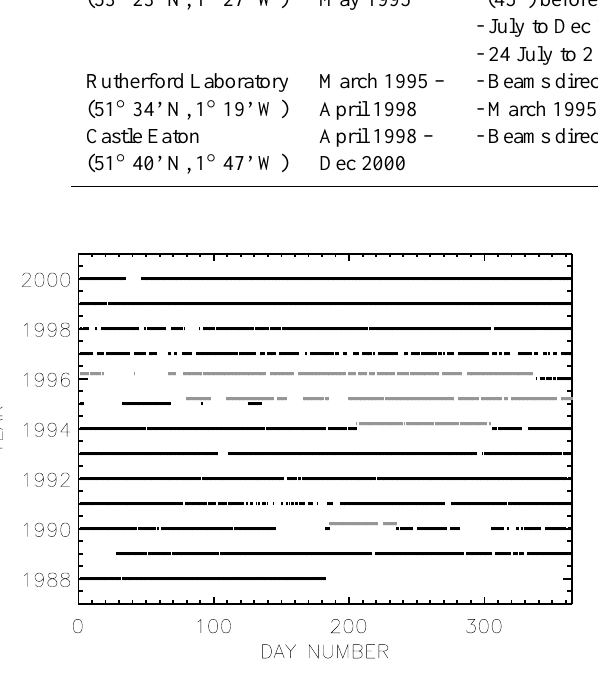
Fig. 1. A schematic representation of the extent of data available from the meteor radar. Lines in black indicate data recorded when two orthogonal aerials were available. Lines in grey indicate data recorded when only one aerial was